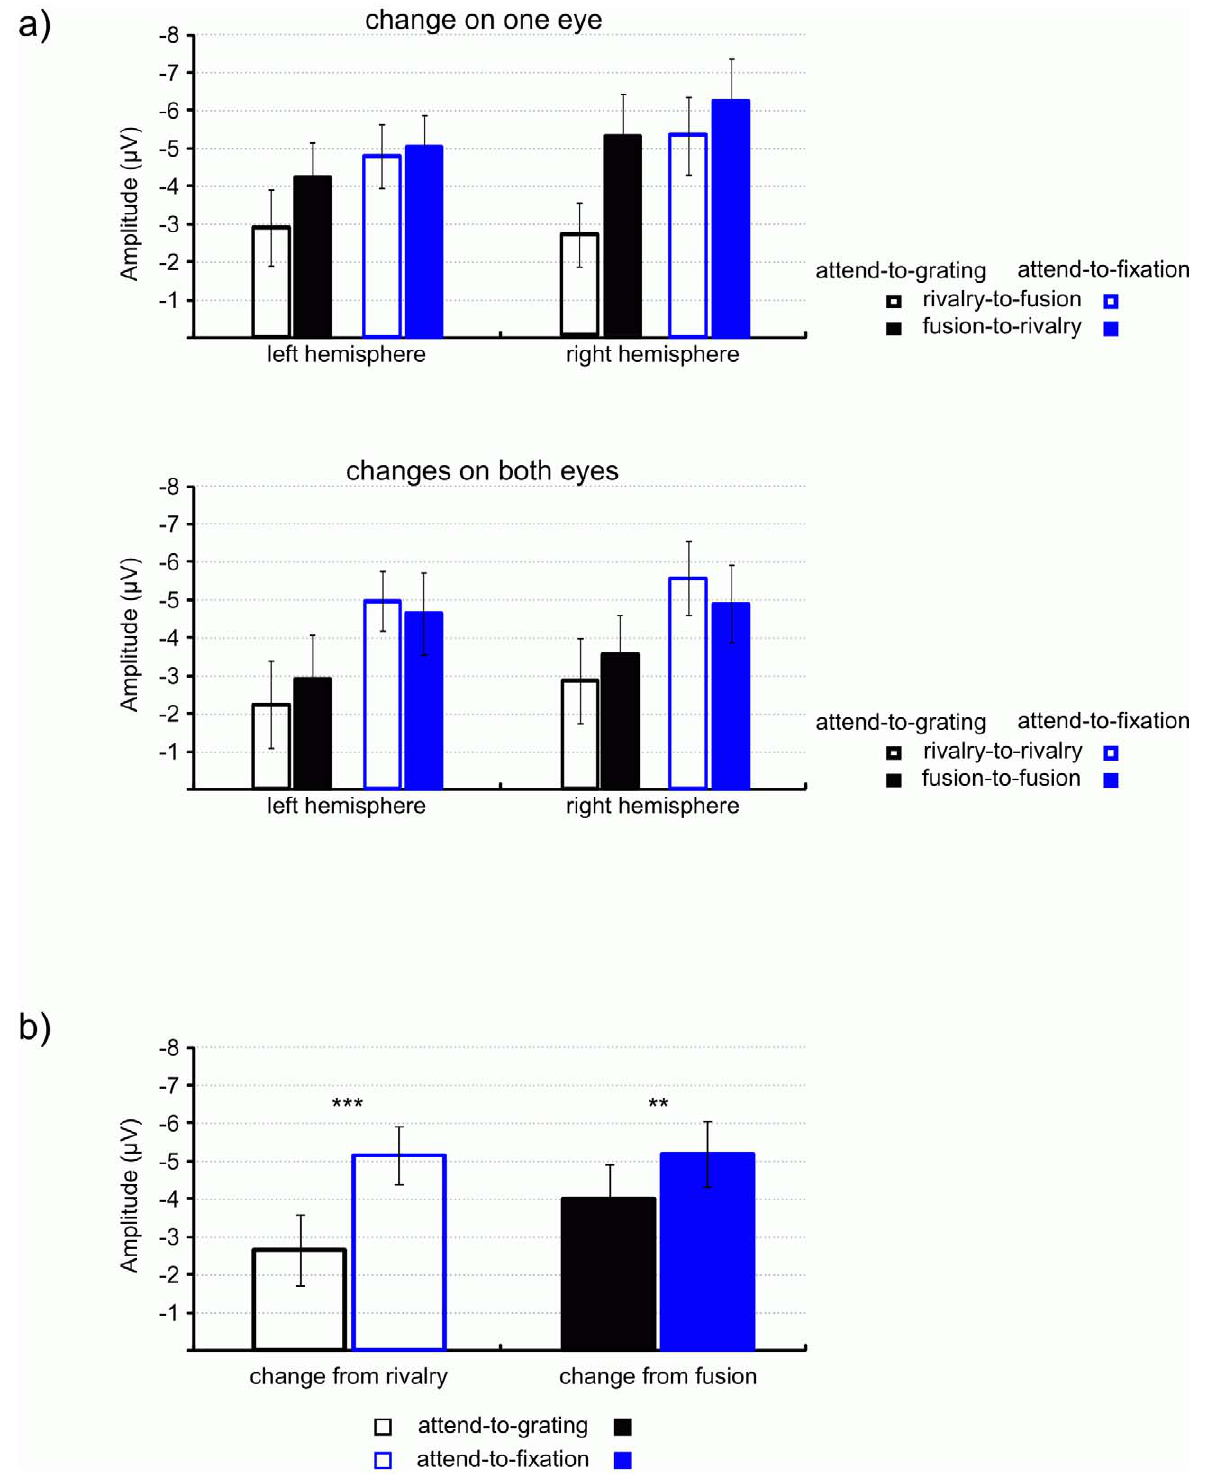
Figure 4. Bar graphs of the N1 averaged in the 160–210 ms time window. (a) Shows the amplitudes for transitions that involved an orientation change on only one eye (top) and for transitions that involved orientation changes on both eyes (bottom) for the attend-to-grating (black) and the attend-to-fixation (blue) conditions. Changes from rivalry are depicted as unfilled bars; changes from fusion are depicted as filled bars. (b) Plots the significant two-way interaction between condition and stimulation before transition (rivalry, fusion).